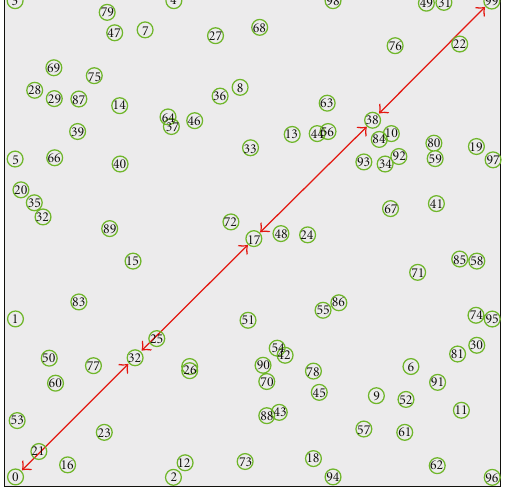
Figure 5: A snapshot of the network after RPCM is